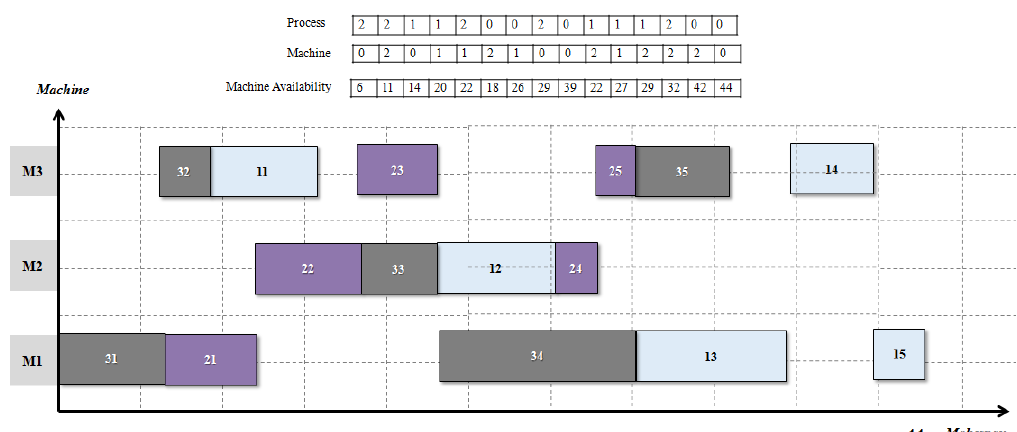
Figure 10. A predictive solution found by FSA 1.